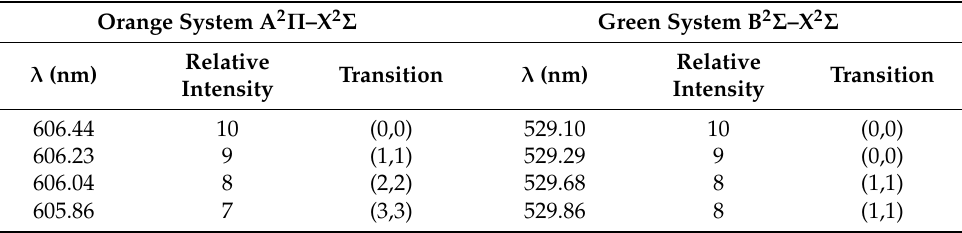
Table 3. Most intense CaF headbands in the “orange and green systems” observed in the LIBS spectra of the green and pale green